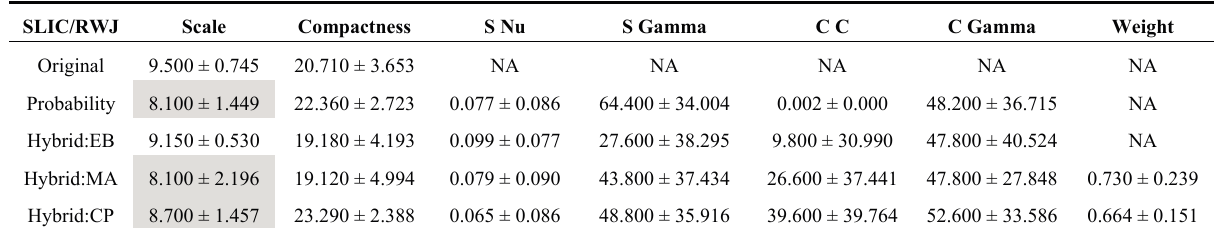
Table 6. Parameters generated for the Bokolmanyo problem instance.